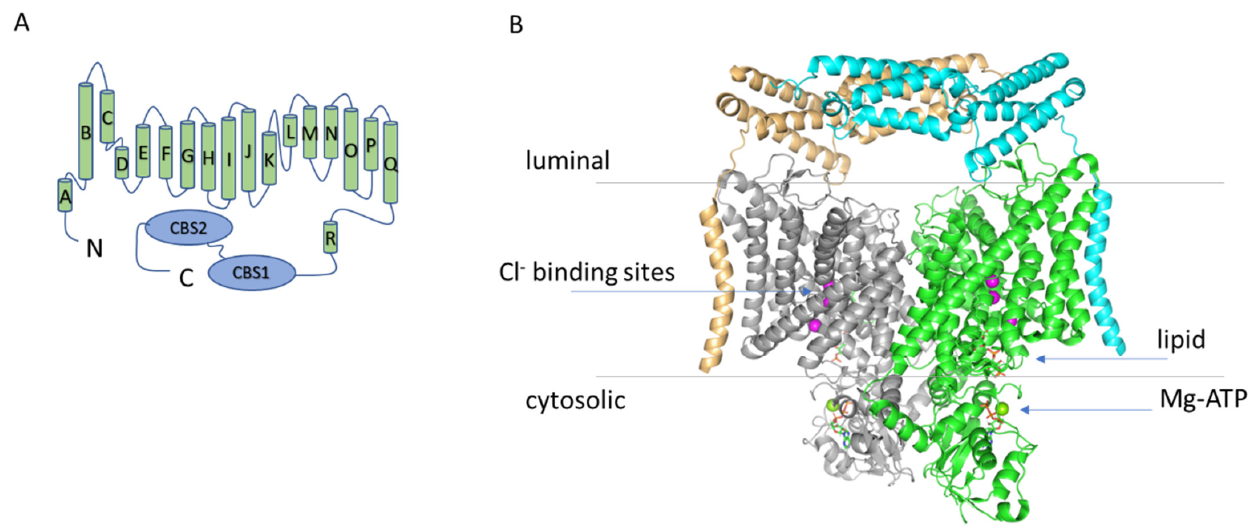
Figure 1. ( A ) Topology diagram of ClC-7. ( B ) Structure of the hClC-7/Ostm1 complex. Structure of the hClC-7/Ostm1 complex based on the work of Schrecker et al. (PDB entry 7JM7) viewed from the membrane plane [6]. The two ClC-7 subunits are represented in grey and green, the two Ostm1 subunits in orange and cyan. The blue arrows indicate the three anion binding sites in the permeation pathway (magenta spheres) and the location of the lipid and of the Mg-ATP (only in the green subunit). The cytosolic C-terminal region of the protein comprises two so called CBS (cystathionine β synthase) domains.